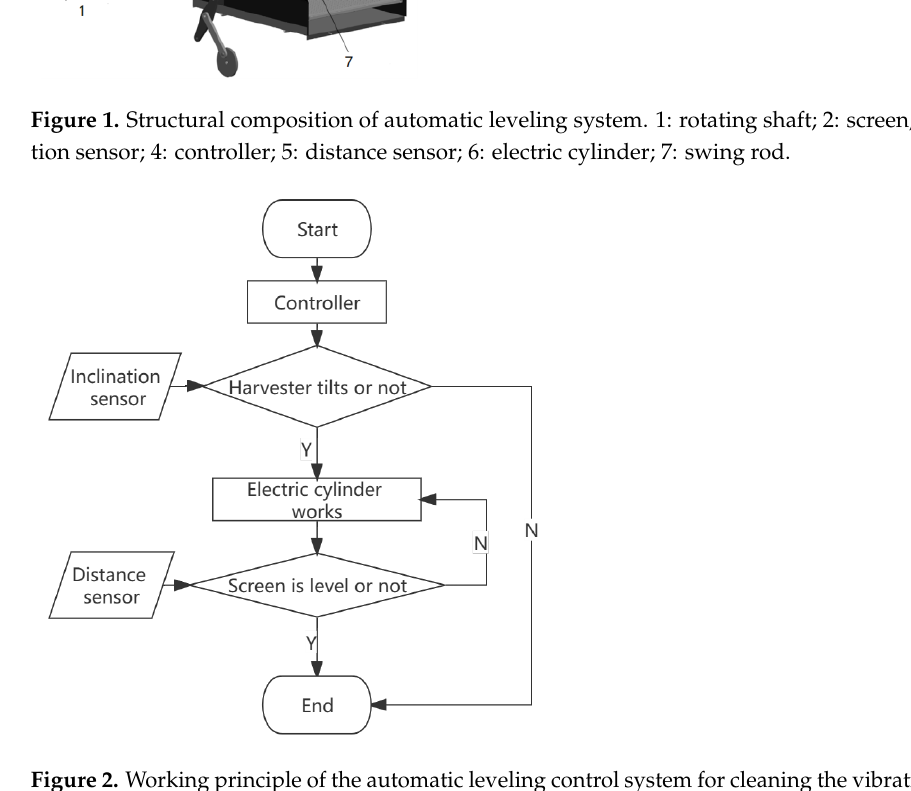
Figure 2. Working principle of the automatic leveling control system for cleaning the vibrating screen.